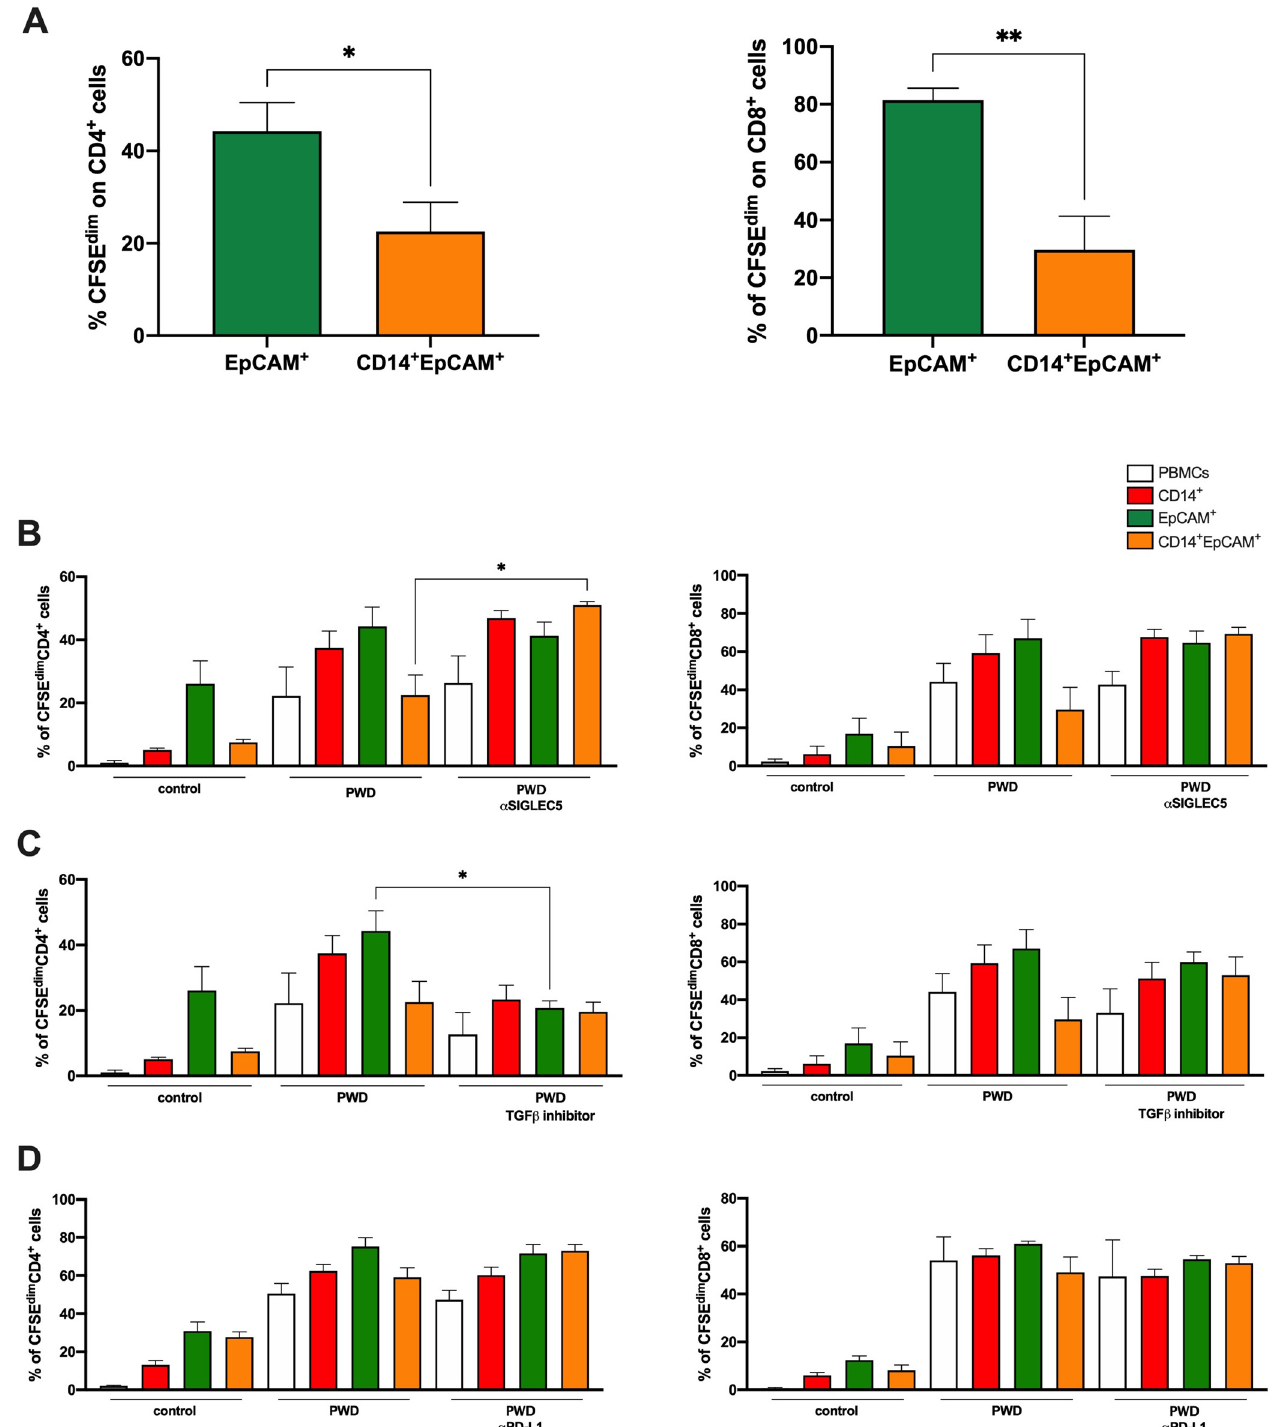
Figure 6. Sorted THCs inhibit CD4 + T cell proliferation in a SIGLEC5-dependent manner. ( A ) Proliferation of CD4 (left) and CD8 (right) T lymphocytes after a 5-day co-culture with pokeweed (PWD) stimulated sorted SW620 CSC (EpCAM + , green) and THCs (CD45 + CD14 + EpCAM + , tangerine). Proliferation of CD4 (left panels) and CD8 (right panels) T lymphocytes after a 5-day co-culture with pokeweed (PWD)-stimulated PBMCs (white), sorted human monocytes (CD14 + , red), SW620 CSC (EpCAM + , green) and THCs (CD45 + CD14 + EpCAM + , tangerine) in the presence or absence of a blocking antibody or inhibitor against ( B ) SIGLEC5; ( C ) TGF β ; and ( D ) PD-L1. N = 6; *, p < 0.05; and **, p < 0.01.